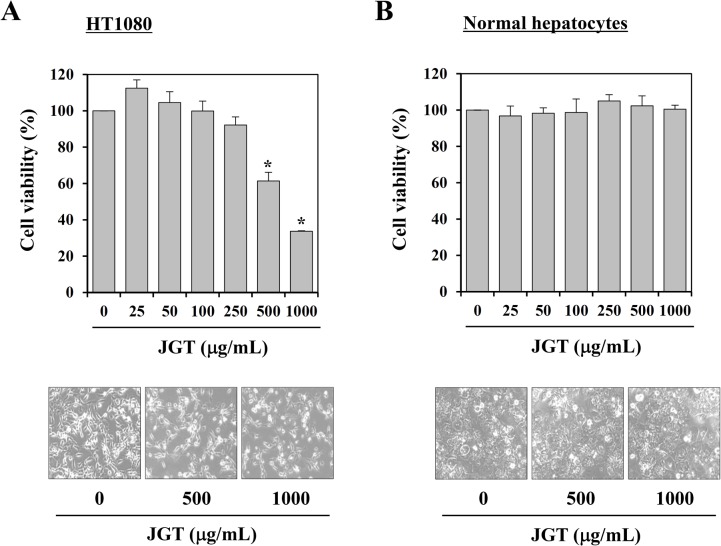
The effects of JGT on cell viability and apoptotic morphological changes.Human fibrosarcoma HT1080 cells (A) and murine hepatocytes (B) were treated with the indicated doses of JGT for 48 h, and cell viability was determined using MTT assays. JGT-treated cells were observed under an inverted microscope (40× magnification). Data are representative of three independent experiments performed in triplicate and are expressed as means ± SD. * p < 0.05 vs. untreated control.